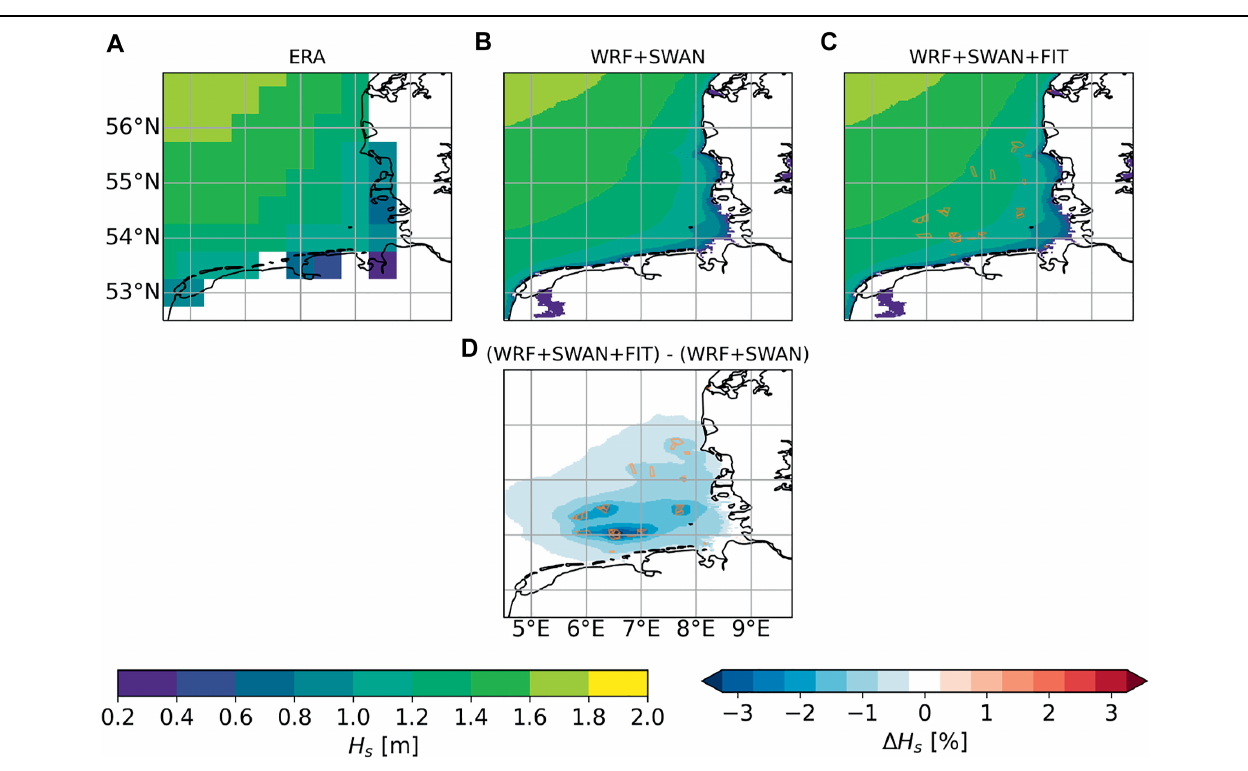
outliers due to small wind speeds in WRF, which are used for normalization. Thus, the positive means for the relative differences for “onshore” and “all” are artifacts of those outliers. Medians, being less affected by outliers, are negative for all areas (dotted